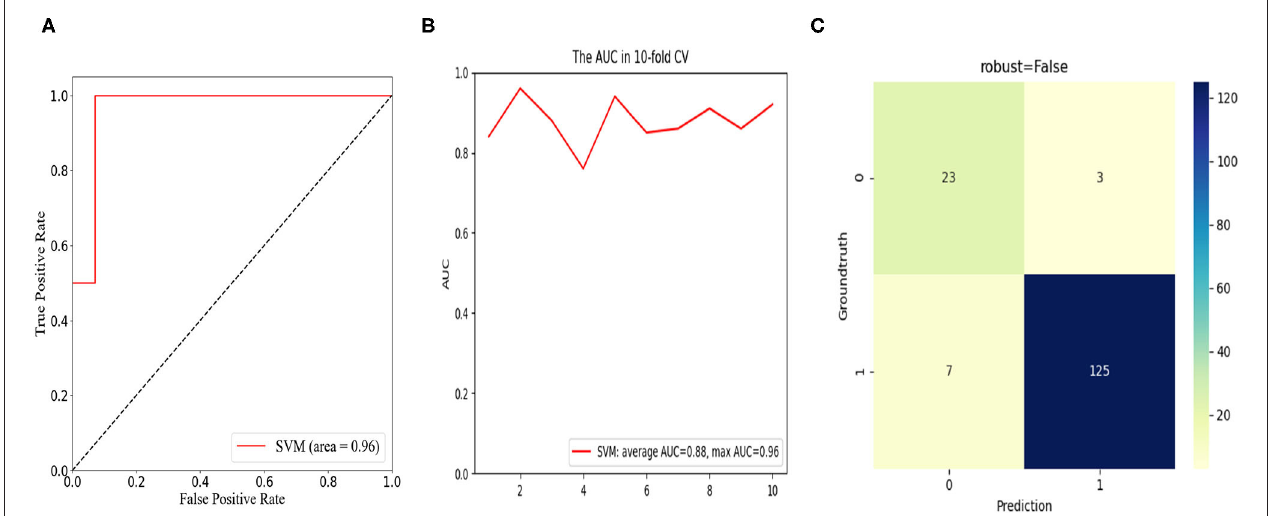
FIGURE 5 | In the short-term cohort, receiver operation characteristic (ROC) curve analysis of the SVM model with the maximum value of 0.96 (A) ; ROC curve analysis of 10-fold cross validation of the SVM model for predicting the risk of unfavorable clinical outcomes following LIF with average AUC of 0.88 and max AUC of 0.96 (B) ; confusion matrix of the SVM model (C) .